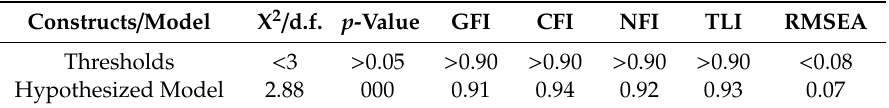
Table 4. Goodness of